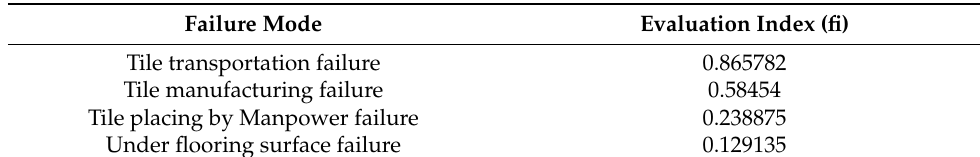
Table 10. Evaluation index for each failure mode.